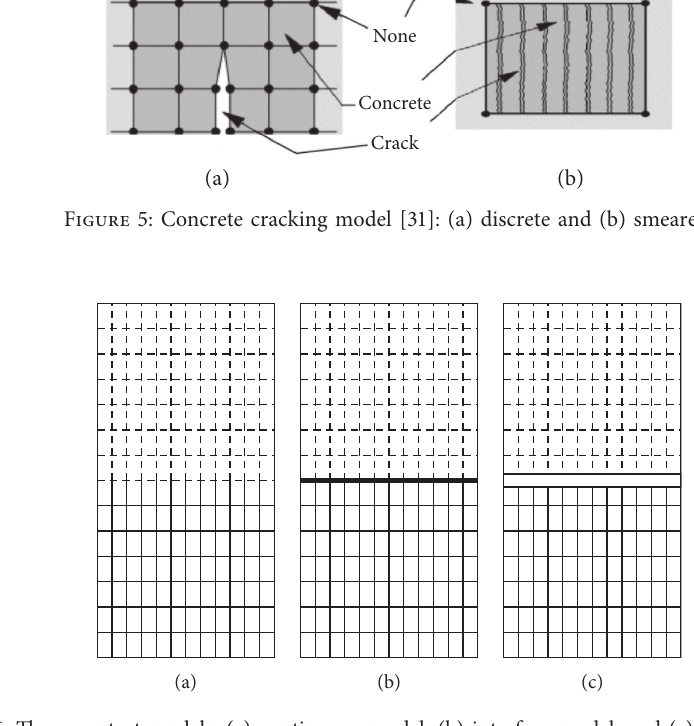
Figure 6: Three contact models: (a) continuous model, (b) interface model, and (c) thin-layer